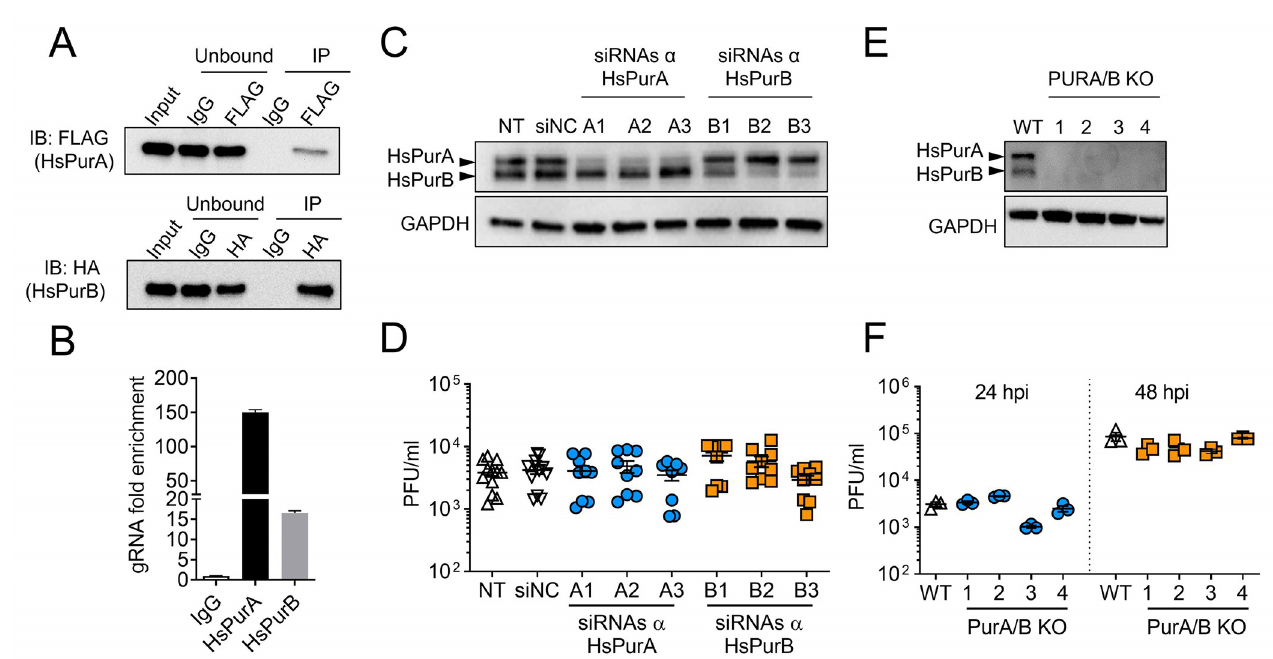
Fig 4. Human PurA and PurB interactions with DENV RNA and effect on infection in human cells. (A) Western blots of FLAG-tagged HsPurA and HA- tagged HsPurB immunoprecipitates from Huh7 cells 24 hpi with DENV2 at a MOI of 5. (B) gRNA and sfRNA fold enrichments in FLAG-tagged HsPurA and HA-tagged HsPurB immunoprecipitates as compared to IgG control. Bars show mean ± s.e.m. from two repeats. (C) Western blots of HsPurA and HsPurB from cells silenced for either of the HsPUR proteins. Three different siRNAs were used for each protein. The picture is representative of multiple repeats. GAPDH was used as a loading control. (D) Effect of HsPURA or HsPURB silencing on viral load estimated by plaque forming unit (PFU) quantities in supernatants at 24 hpi with a MOI of 0.1. Bars indicate means ± s.e.m. (E) Western blots of HsPurA and HsPurB from cells, where both proteins were genetically-depleted. Four different double knock-out lines (PURA/B KO) for each protein were tested. The picture is representative of multiple repeats. GAPDH was used as a loading control. (F) Effect of HsPurA and HsPurB genetic ablation on viral loads estimated by PFU quantities in supernatants at 24 and 48hpi, with a MOI of 0.1. Bars indicate means ± s.e.m. NT, non-transfected control; siNC, transfected with control siRNA; WT,